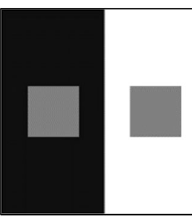
Figure 1. Influence of context on target lightness: two gray targets, despite having the same luminance, appear different in